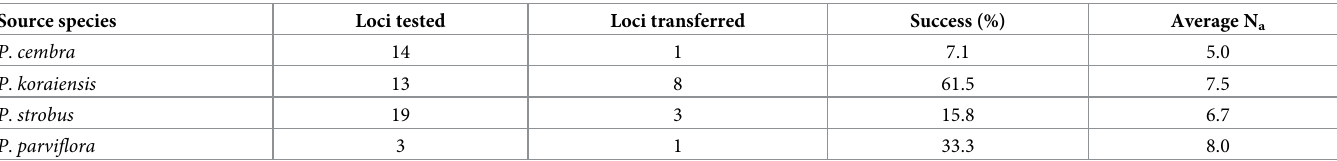
Table 3. Results of microsatellite locus transferability to Pinus albicaulis for primers developed in other Pinus species. Source species Loci tested Loci